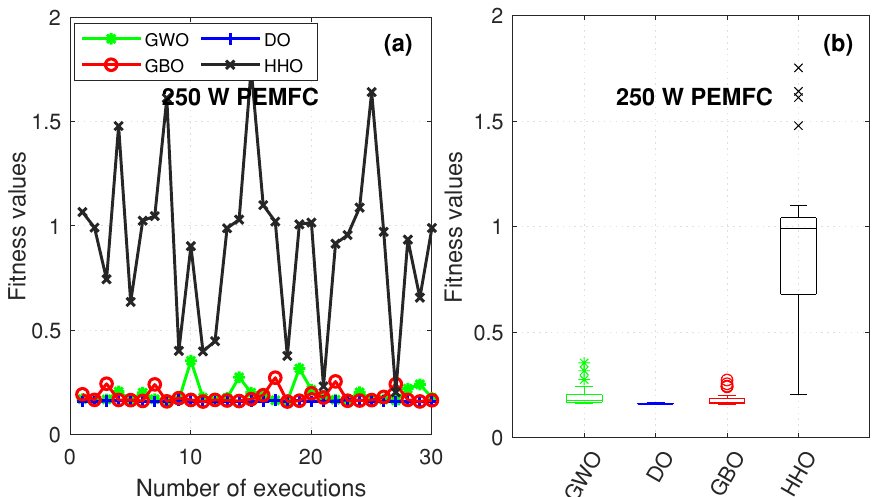
Figure 4. The statistical study of the 250 W after 30 repetitions: ( a ) best values of the objective function; ( b ) boxplot of SSE.